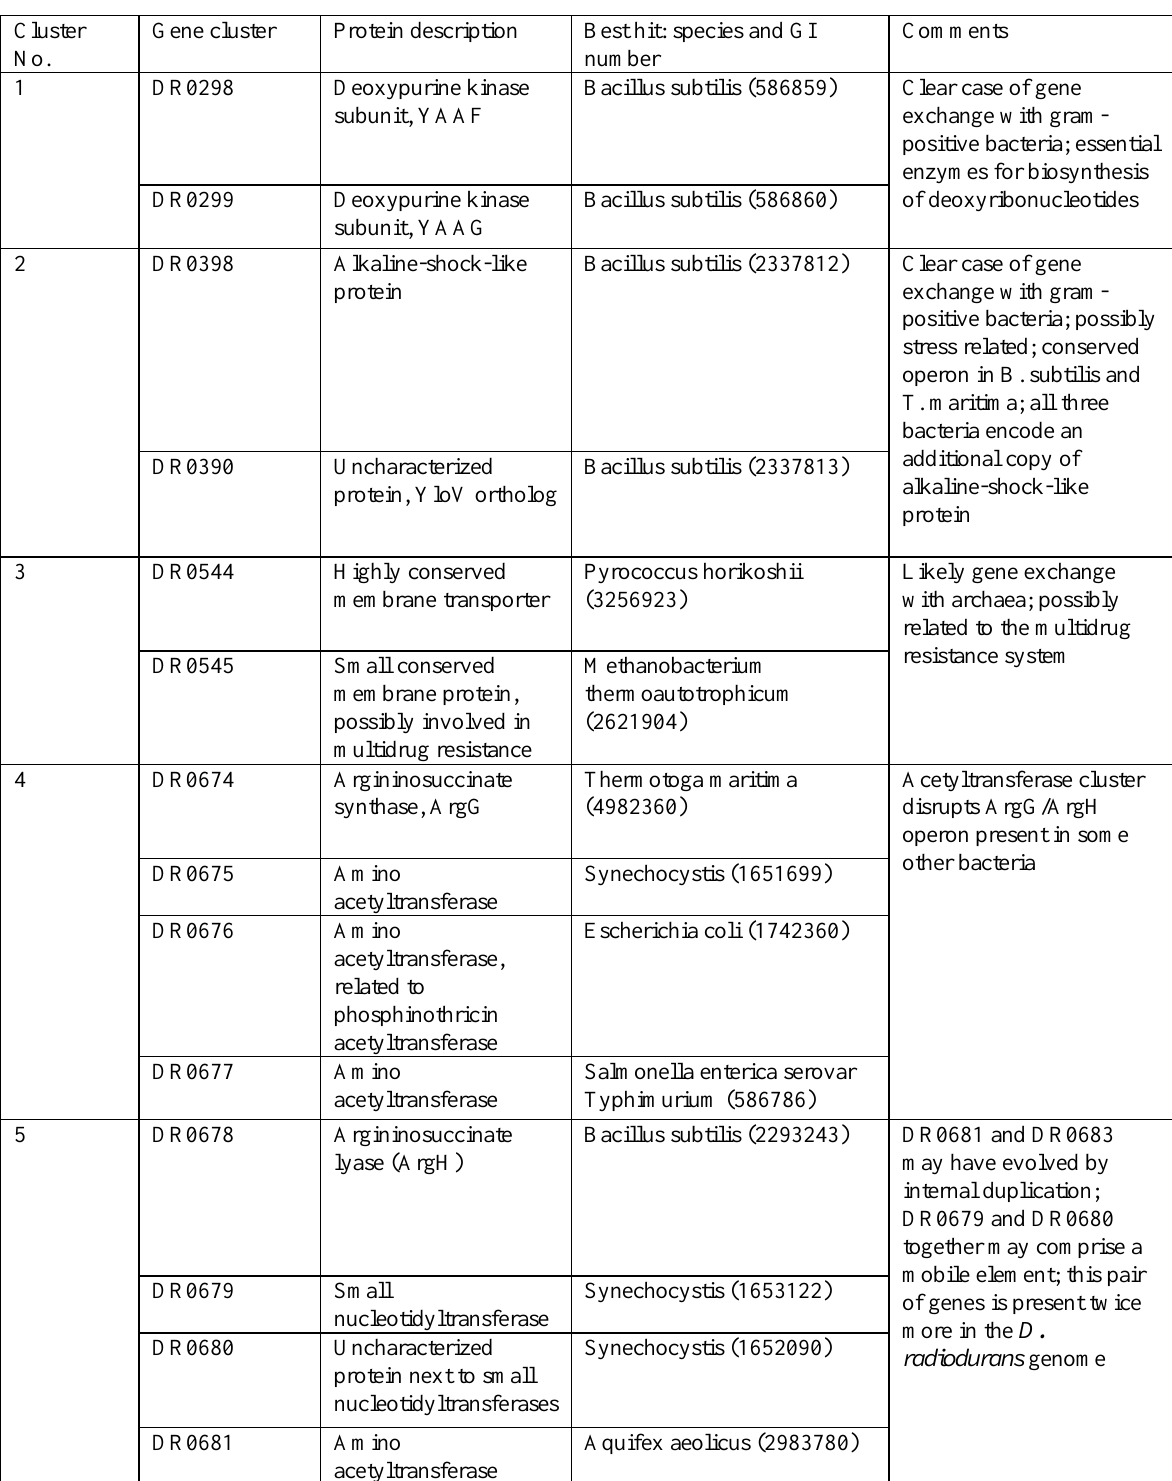
Supplementary Table 10 (S10): List of D. radiodurans genes related to some unusual predicted operons with their operon cluster number, best hit details &